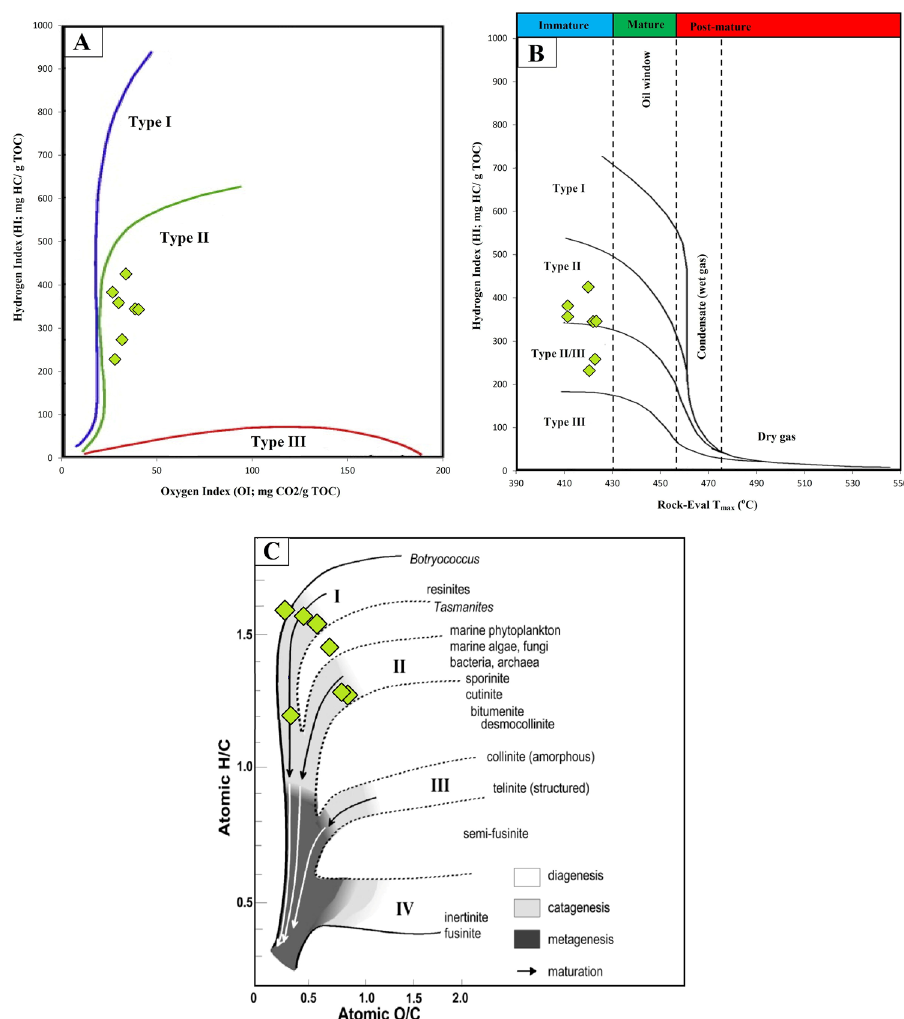
Fig. 10 Geochemical cor- relations between Rock–Eval hydrogen index (HI), oxygen index (OI), and T max , and H/C vs. O/C atomic ratios, showing that the analyzed bituminite shale samples are dominated by oil-prone kerogen types (Type I and II), with small amounts of mixed II/III